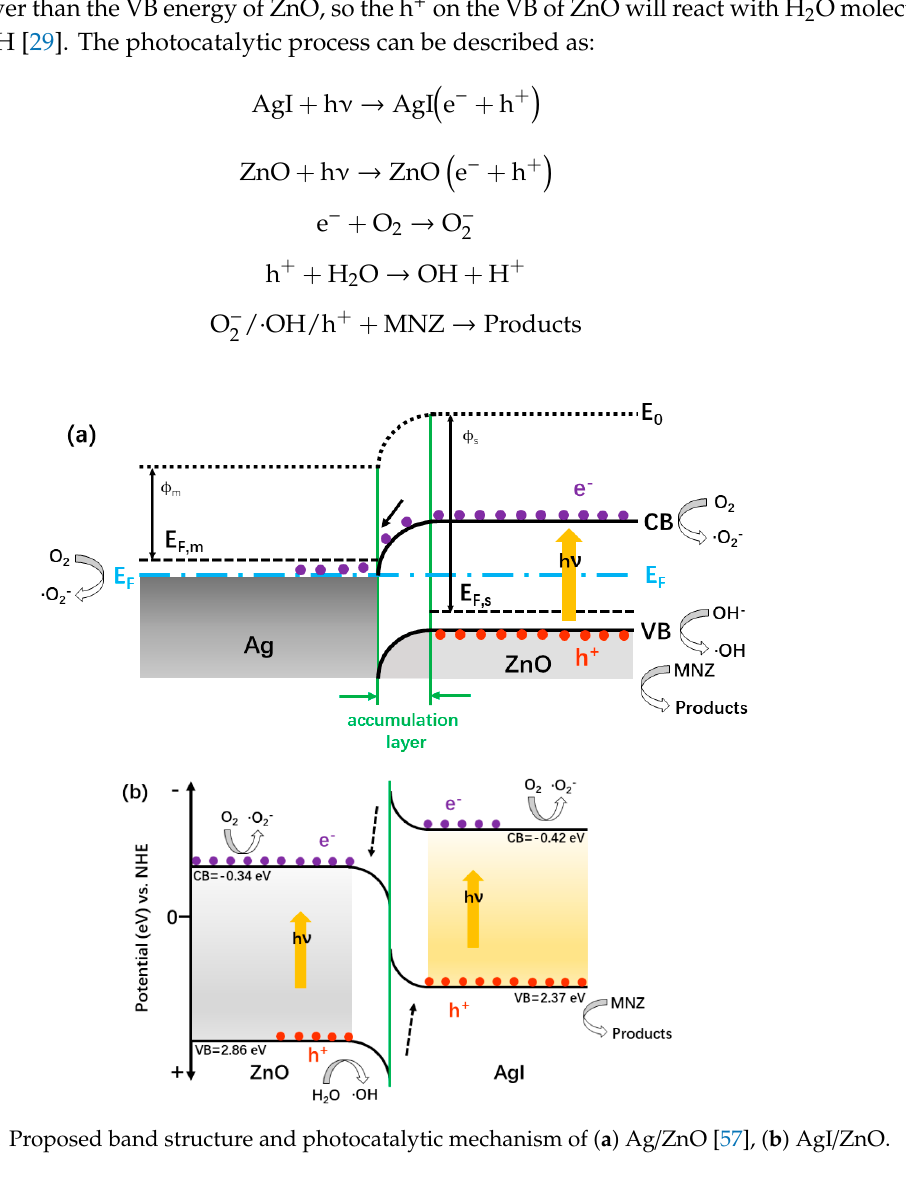
Figure 16. Proposed band structure and photocatalytic mechanism of ( a ) Ag/ZnO [57], ( b ) AgI/ZnO.